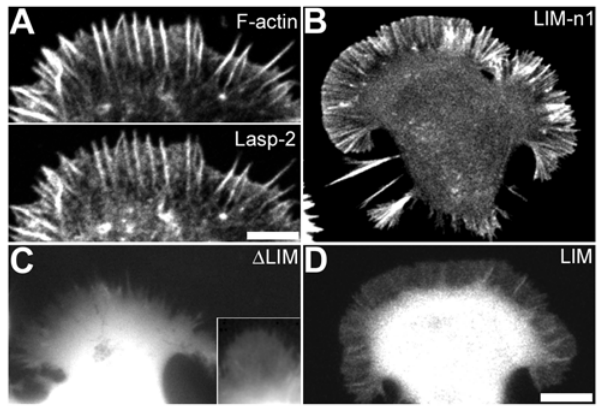
Figure 3. Localization of EGFP-tagged lasp-2 fragments in NG108-15 cells. Cells transfected with EGFP-lasp-2 (A), EGFP-LIM-n1 (B), EGFP- D LIM (C), or EGFP-LIM (D) are shown as indicated. The inset in C shows widely distributed lamellipodial extension. Actin filaments were visualized by staining with rhodamine-phalloidin (F-actin in A). The bars in A and D represent 5 and 10 m m, respectively.